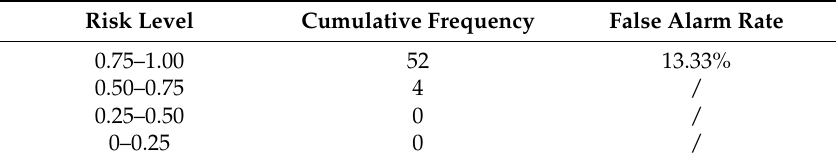
Table 3. The cumulative frequency used to account for the number of real ignition points that fall within each risk level, and the false alarm rate used to account for the case where a higher risk of fire occurrence was predicted but no actual fire